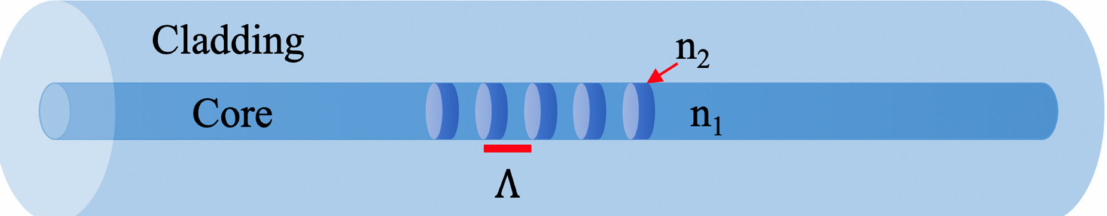
Figure 4. Schematic of an FBG. An optical fibre with inscribed fibre Bragg grating labelling the cladding and the core, the grating spacing and the two different refractive indices within the